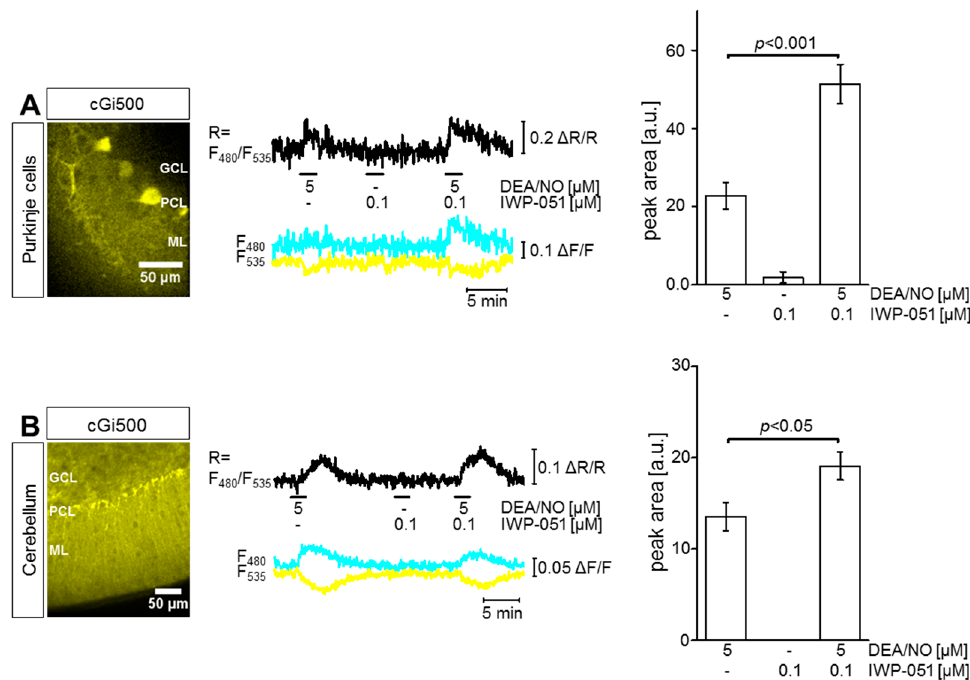
Figure 1. IWP-051 potentiates 2-( N , N -diethylamino)-diazenolate-2-oxide diethylammonium salt (DEA/NO)-induced cGMP signals in Purkinje cells and in the granule cell layer of the cerebellum. ( A ) Förster/fluorescence resonance energy transfer (FRET)-based cGMP imaging was performed in acute cerebellar brain slices from L7Cre;R26-CAG-cGi500(L2) mice with Purkinje cell-specific expression of cGi500. Yellow color represents the YFP fluorescence of cGi500 in Purkinje cells (left). A representative measurement of a Purkinje cell is shown (middle). During measurement, DEA/NO, IWP-051 or a combination of both was applied in the indicated concentrations (middle, black horizontal bars). Black, cyan and yellow traces represent cyan fluorescent protein (CFP)/yellow fluorescent protein (YFP) ratio, CFP trace and YFP trace, respectively. Statistical analysis (right) was performed with peak areas of respective cGMP signals; data are shown as mean ± SEM ( n = 5 ROIs from one brain slice); ( B ) FRET-based cGMP imaging was performed in acute cerebellar brain slices from NesCre;R26-CAG-cGi500(L2) mice expressing cGi500 in neurons and glia cells. Yellow color represents the YFP fluorescence of cGi500 in the cerebellum (left). A representative measurement of the granule cell layer (GCL) is shown (middle). Statistical analysis (right) was performed with peak areas of respective cGMP signals; data are shown as mean ± SEM ( n = 9 ROIs from three brain slices). ML, molecular layer; PCL, Purkinje cell layer.